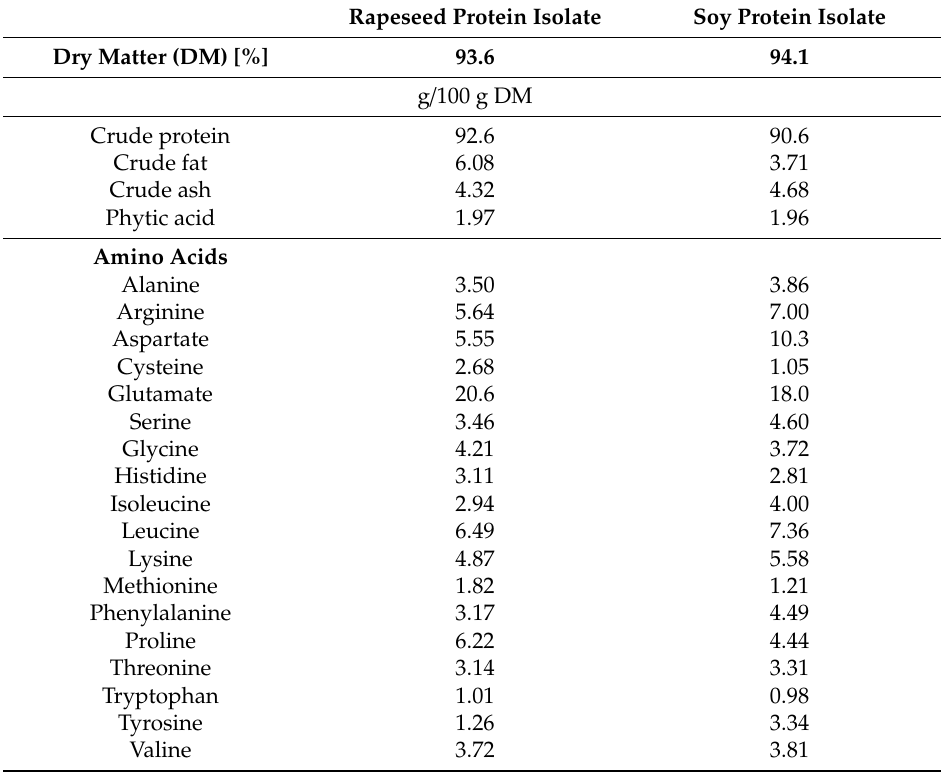
Table 2. Composition of the protein isolates determined by analyses.